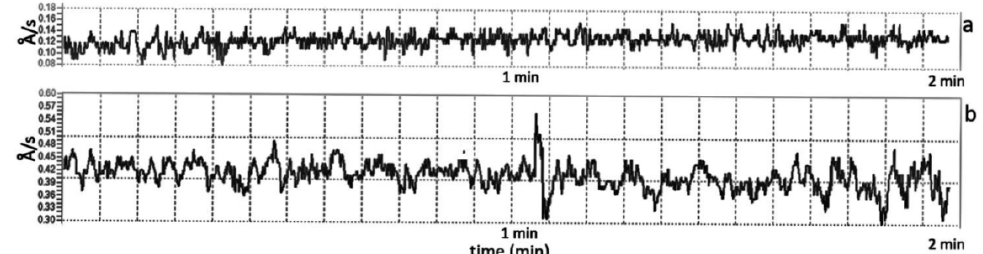
Figure 3. Temporal evolution of the calcium phosphate deposition rate (Å/s) for: ( a ) 50 W (0.13 Å/s mean value) and ( b ) 120 W rf power (0.41 Å/s mean value); at p = 1.2 × 10 − 2 mbarr. The deviation is about 0.01 Å/s for 50 W and 0.1 Å/s for 120 W.